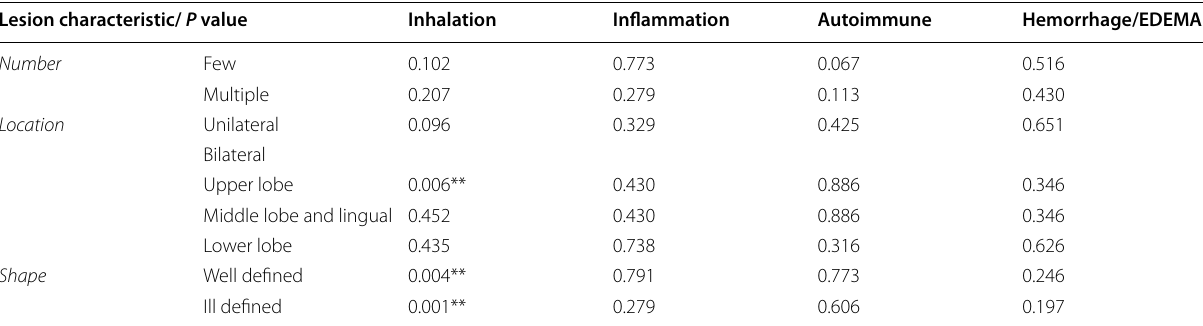
Fig. 4 A 43-year-old male, smoker over the last 20 years, HRCT lungs ( a ) axial, ( b ) coronal sections showed diffuse ill-defined faint ground glass centri-lobular nodules scattered all over the lung lobes bilaterally more prominent at upper lobes. Radiological and clinical diagnosis was made of inhalation lung disease as smoking related-respiratory bronchiolitis (RB) Table 2 The significance of inhalation, inflammatory, autoimmune and edema/hemorrhagic lung diseases regarding lesion distribution and shape